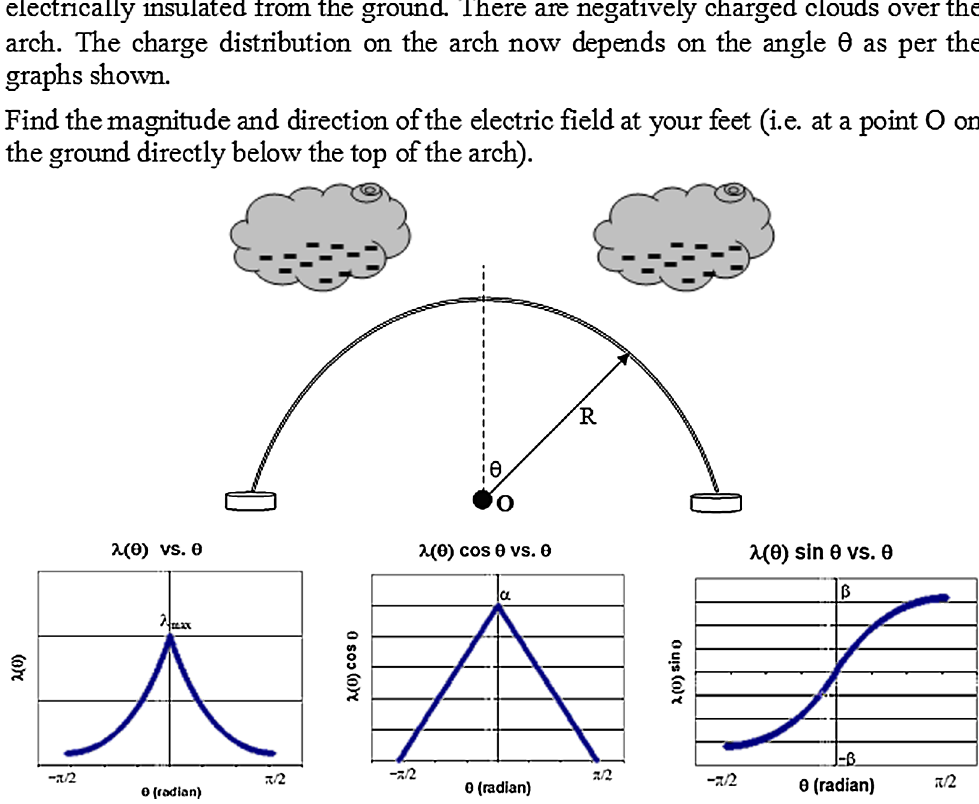
FIG. 4 (color online). The arch problem (interview